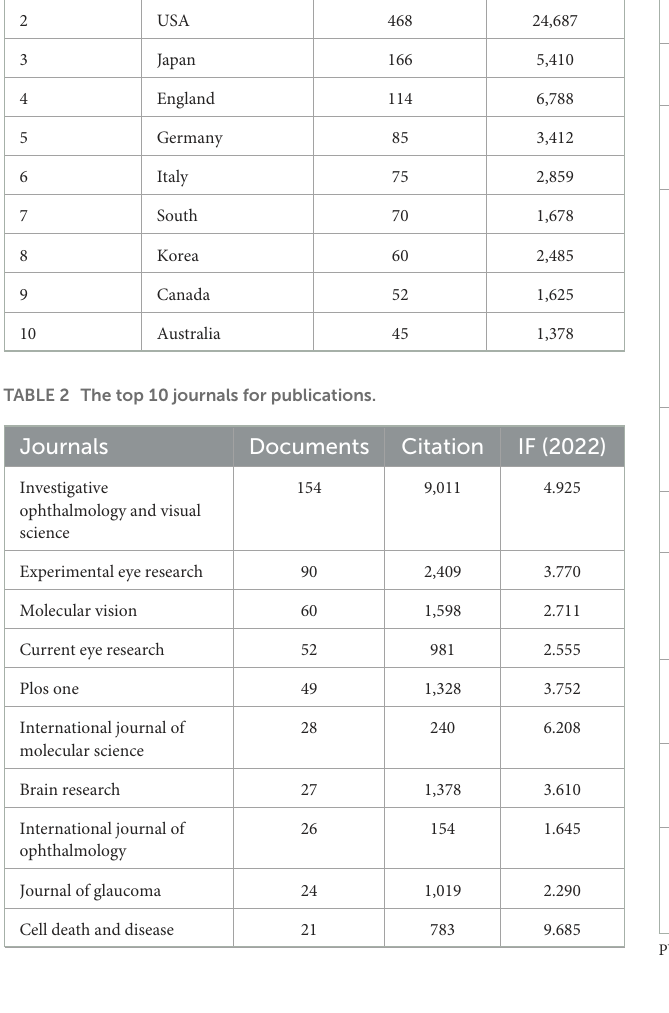
TABLE 4 The top 10 productive